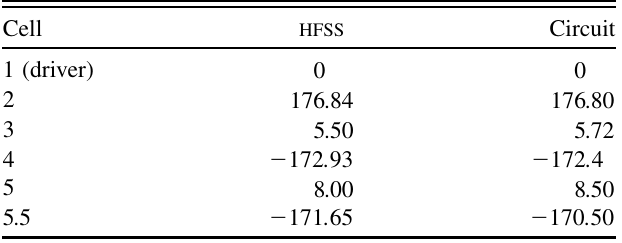
TABLE III. Electric field phase (deg) comparison between HFSS and circuit model.